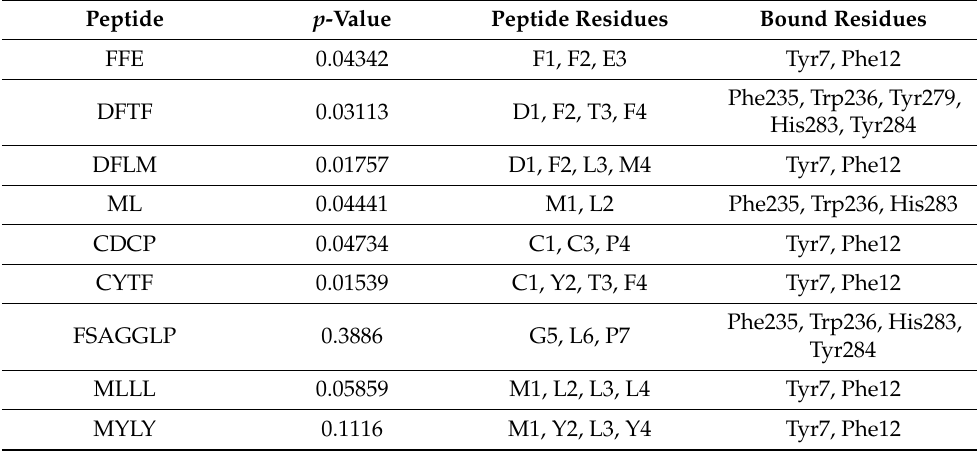
Table 2. Pepsite 2 analysis of the selected peptides using cholesterol esterase as a protein receptor.